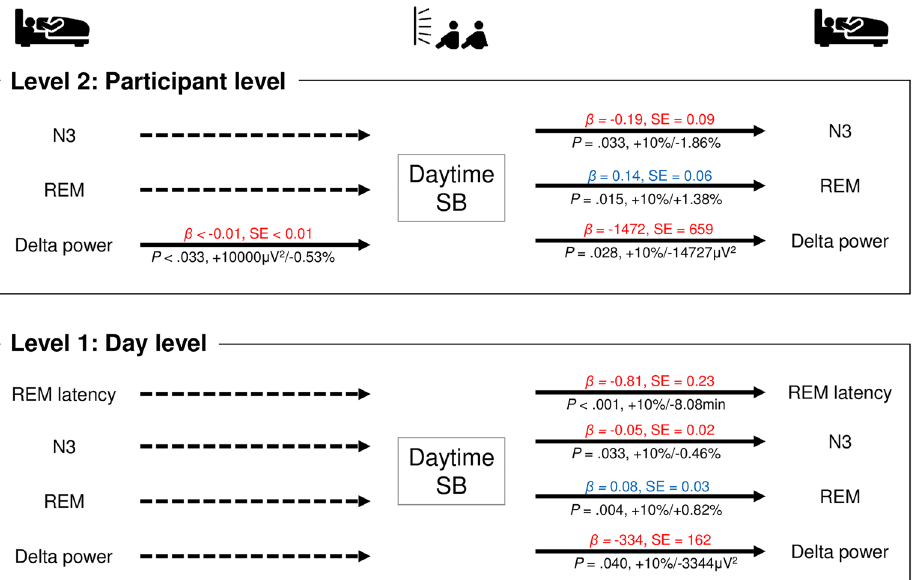
Figure 2. Bidirectional associations between sleep parameters and sedentary behavior. Adjusted for age; sex; BMI; history of smoking, alcohol consumption, and caffeine consumption; and medical history of hypertension, hyperlipidemia, and depressive symptoms. SB sedentary behavior; the solid line represents significant relevance. A solid line on both sides indicates bidirectionally related parameters, and a solid line on one side and a dashed line on the other side indicate only temporally related parameters. Blue text indicates a positive relationship, and red text indicates a negative